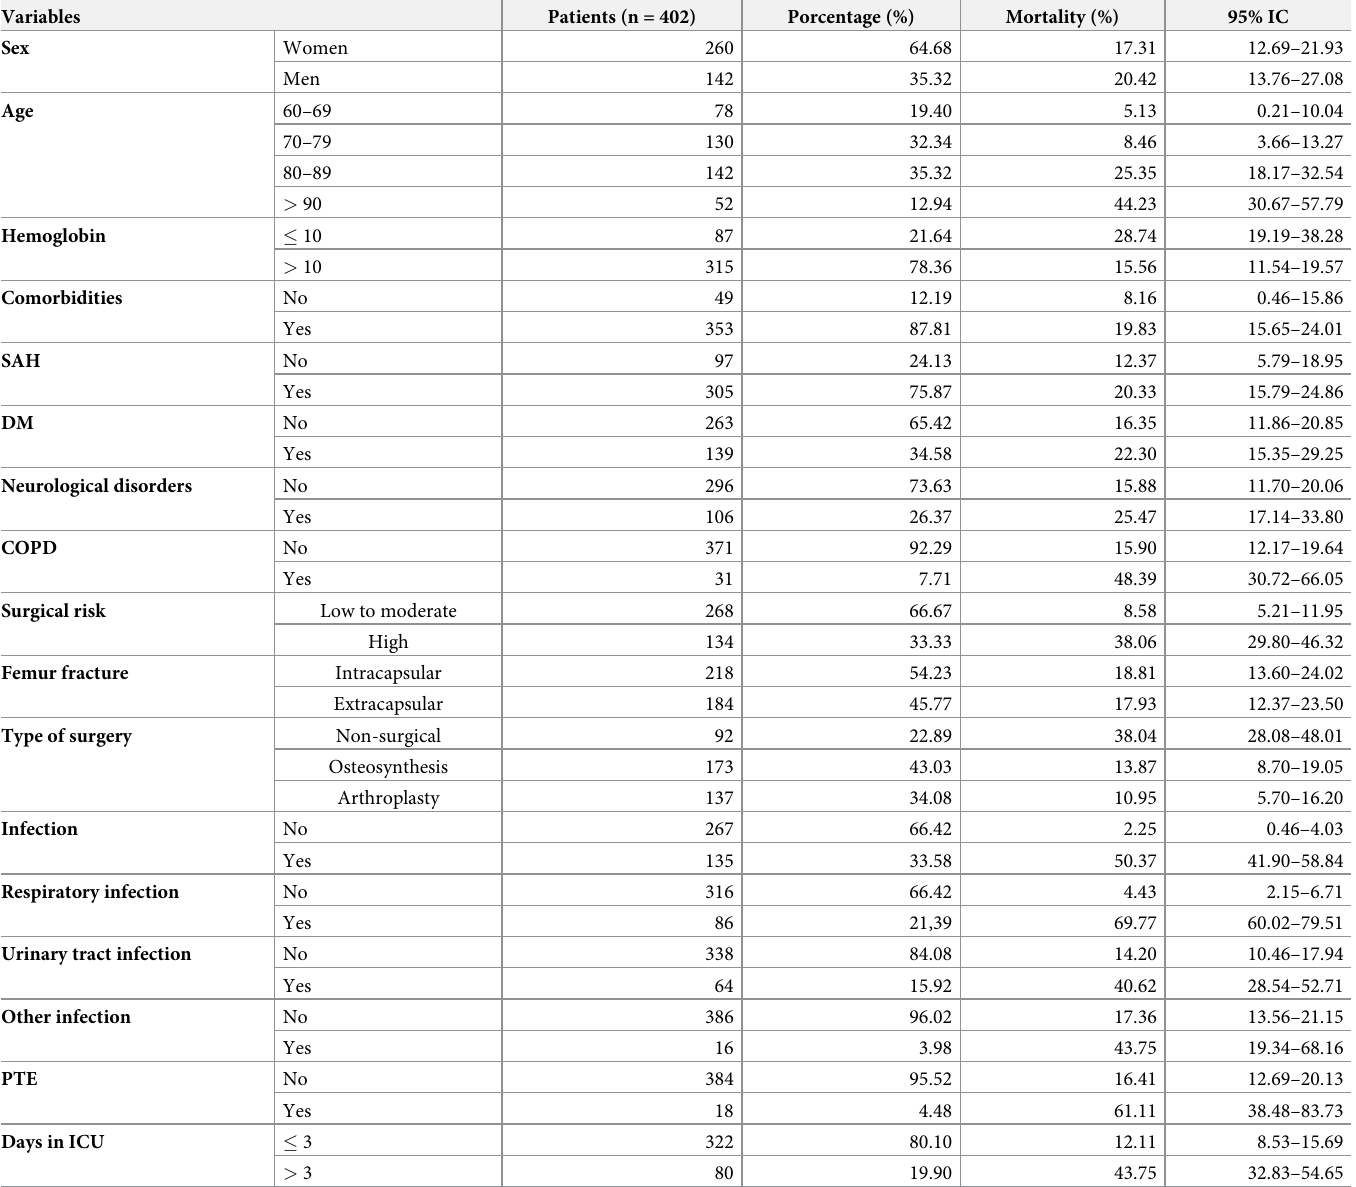
Table 2. Characteristic of patients and